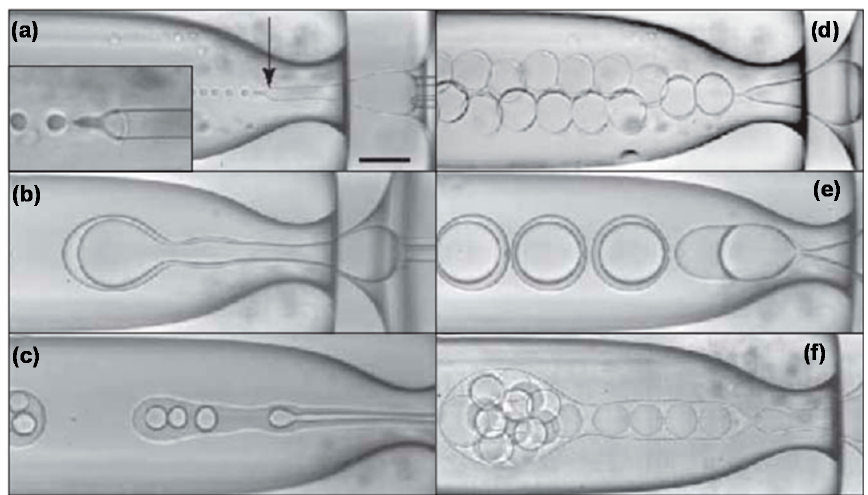
Figure 3. Double emulsion formation in glass capillary device in different regimes: ( a ) Narrowing jetting of inner and middle fluid; ( b ) Widening jetting of both fluids with the same break-up frequency of inner and outer drops; ( c ) Widening jetting of both fluids with different break-up frequencies of inner and outer drops; ( d ) Dripping of both fluids resulting in highly uniform core/shell drops; ( e ) Shortened jetting of both fluids. The flow pattern is similar to ( b ) but the jet length is smaller; ( f ) Extended jetting of middle fluid and dripping of inner fluid resulting in encapsulation of many inner drops in outer drops but the number of inner drops cannot be precisely controlled. The scale bar is 200 µm. Reproduced with permission from Utada et al. [14], publisher by The American Association for the Advancement of Science, 2005.